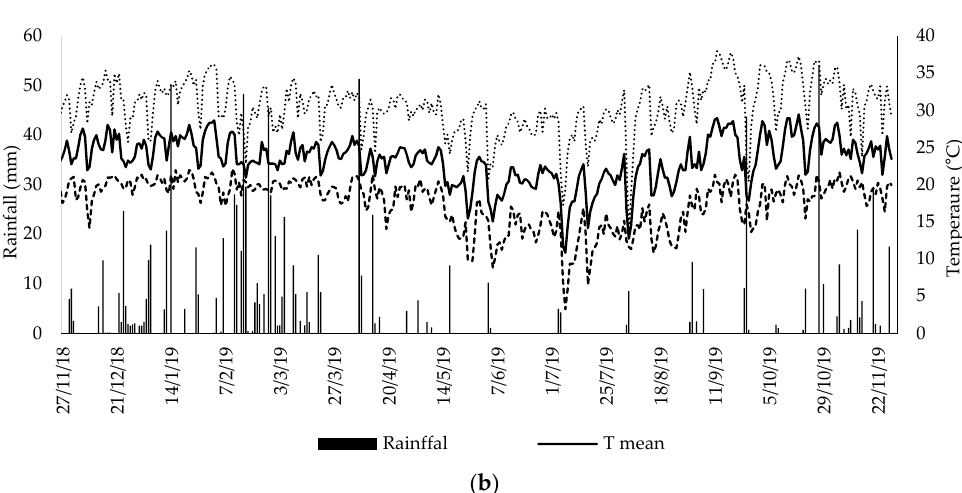
Figure 1. Daily ambient temperature (minimum, mean, and maximum; T; °C) and daily precipitation (P; mm). Data were obtained from the Agrometeorological Station, Department of Exact Sciences, FCAV/UNESP, located 1.5 km from the experiment site. Experiment 1 ( a ) and 2 ( b ).